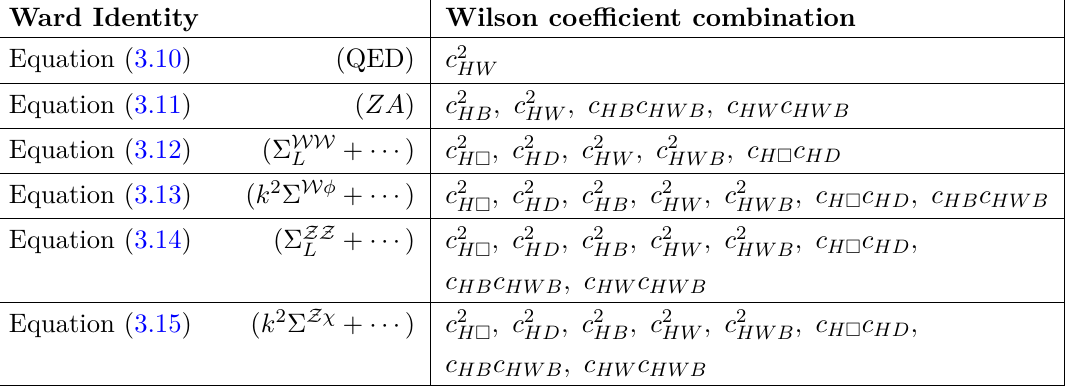
Table 1 . A summary table of the Ward Identities which are violated for each combination of Wilson coefficients, c , when field redefinitions are not properly maintained to O (1 / Λ 4 ) . The i c j combinations, c and c for all c , c c HB , c c HW , c c HWB , c HB c HW , do not H c i HD c i i H (cid:3) H (cid:3) H (cid:3)